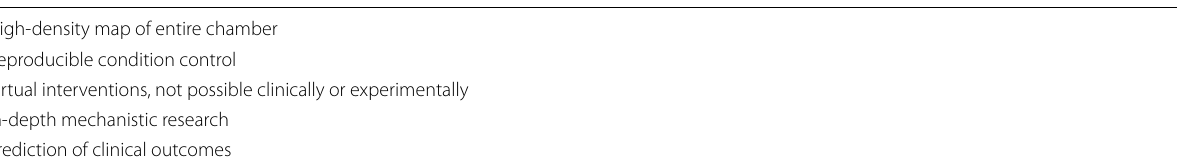
Table 1 Applications of AF computational modeling High‑density map of entire